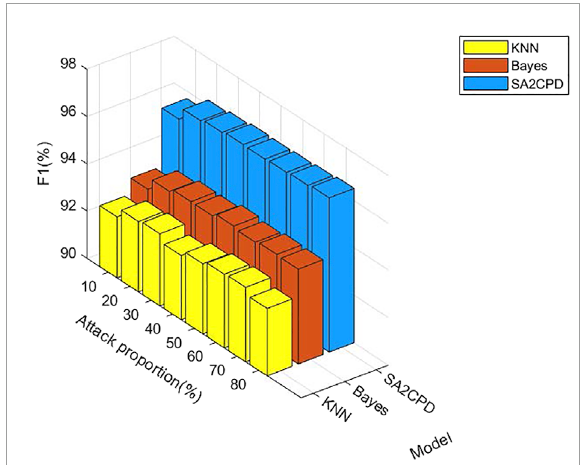
FIGURE 10 The F1 score of our SA2CPD model, the Naive Bayes model and the KNN model under different attack